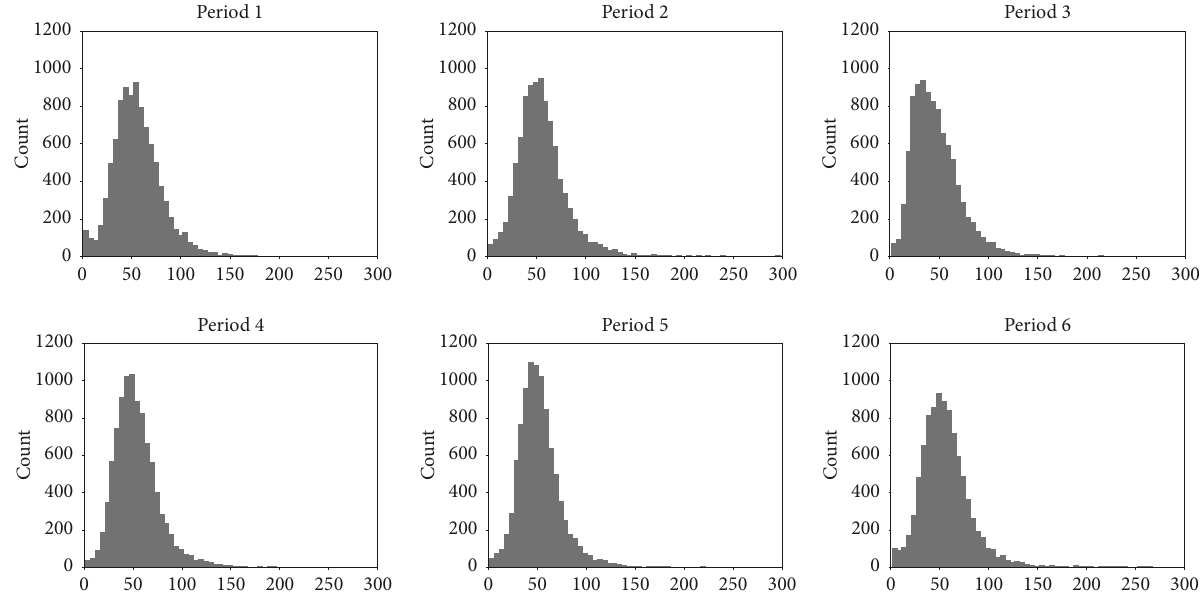
Figure 6: Histograms of the maximum number of pick-ups and drop-offs within an operation zone of each taxi in every period.